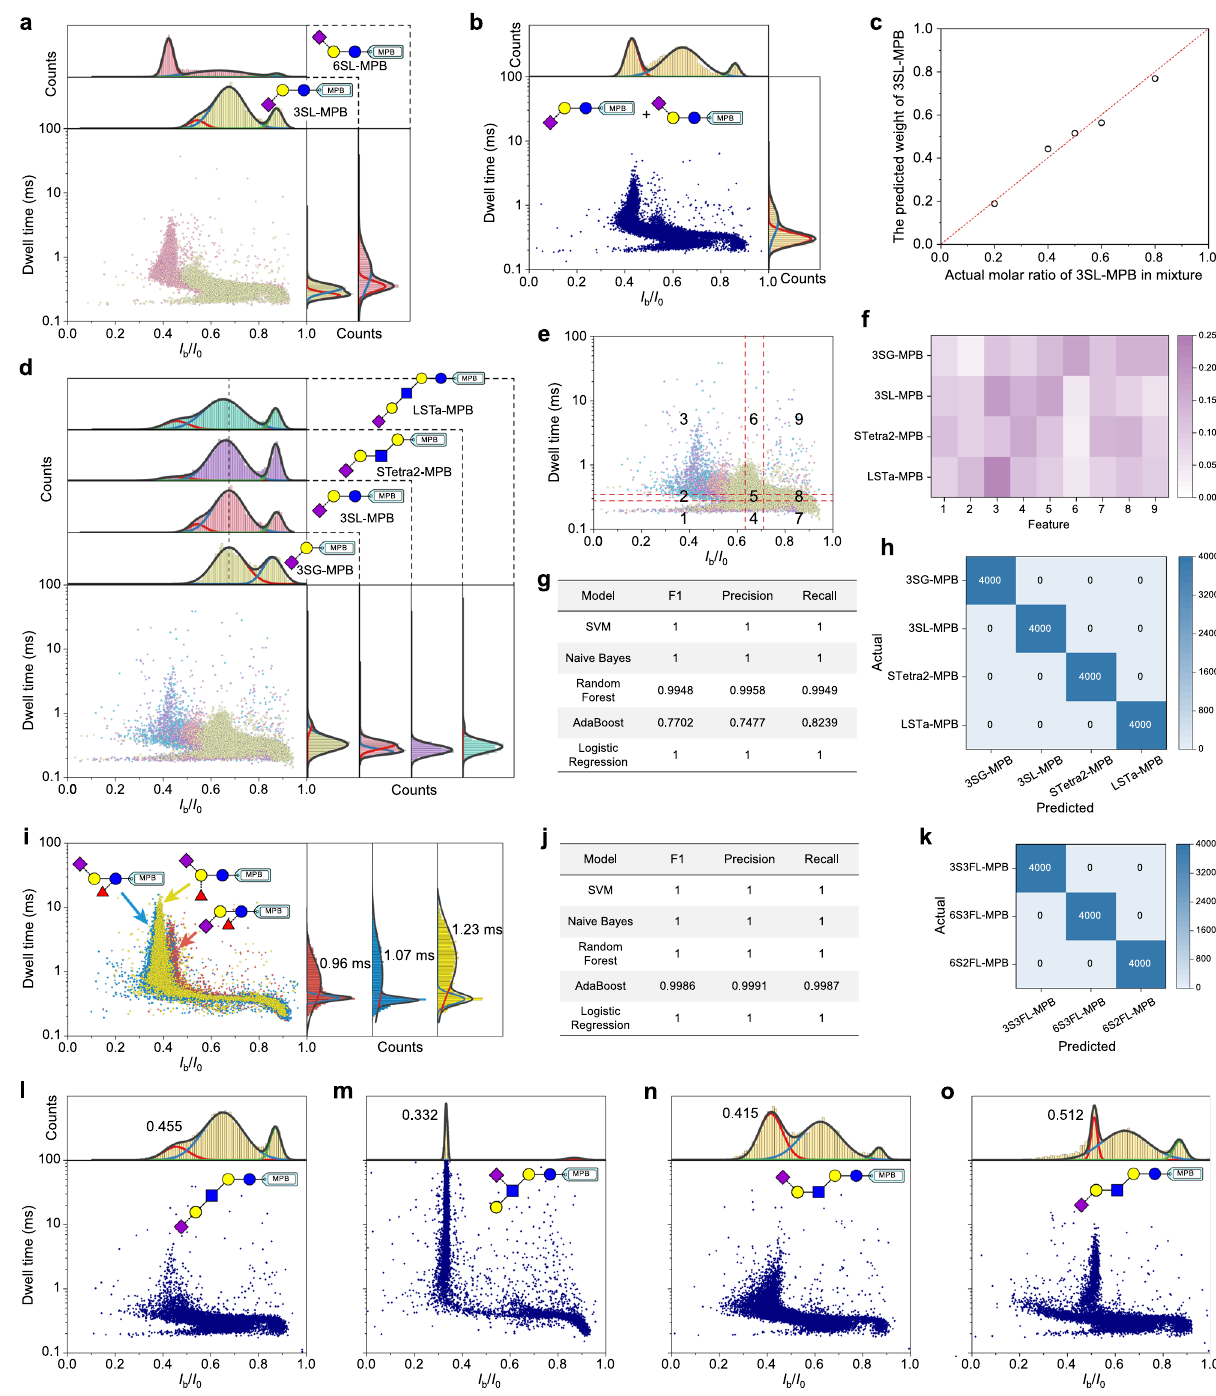
Fig. 2 | Identi fi cation of different glycans. a Superimposed scatter plots and the corresponding I b / I 0 and dwell time distributions of 3SL-MPB and 6SL-MPB. b Scatter plots and the corresponding I b / I 0 and dwell time distributions of the equimolar mixture of 3SL-MPB and 6SL-MPB. c The predicted weights of 3SL-MPB against the actual molar ratios in mixtures. d Superimposed scatter plots and the corresponding I b / I 0 and dwelltime distributions ofMPB-tagged disaccharide(3SG- MPB), trisaccharide (3SL-MPB), tetrasaccharide (STetra2-MPB), and pentasacchar- ide (LSTa-MPB). e , Equal frequency binding of the scatter plot from all events of four glycans. f The normalized heat mapof 9 features of four glycans. g Evaluation resultsof fi vemodelsintermsofF1,Precision,andRecallscores.Thesescoreswere the mean values of 10 replicates, each replicate consists of 100 training and test cycles. h ConfusionmatrixofSVMmodelfromtheaccumulatedpredictionresultof 4000 test sets after 10 replicates. One training and test cycle includes the